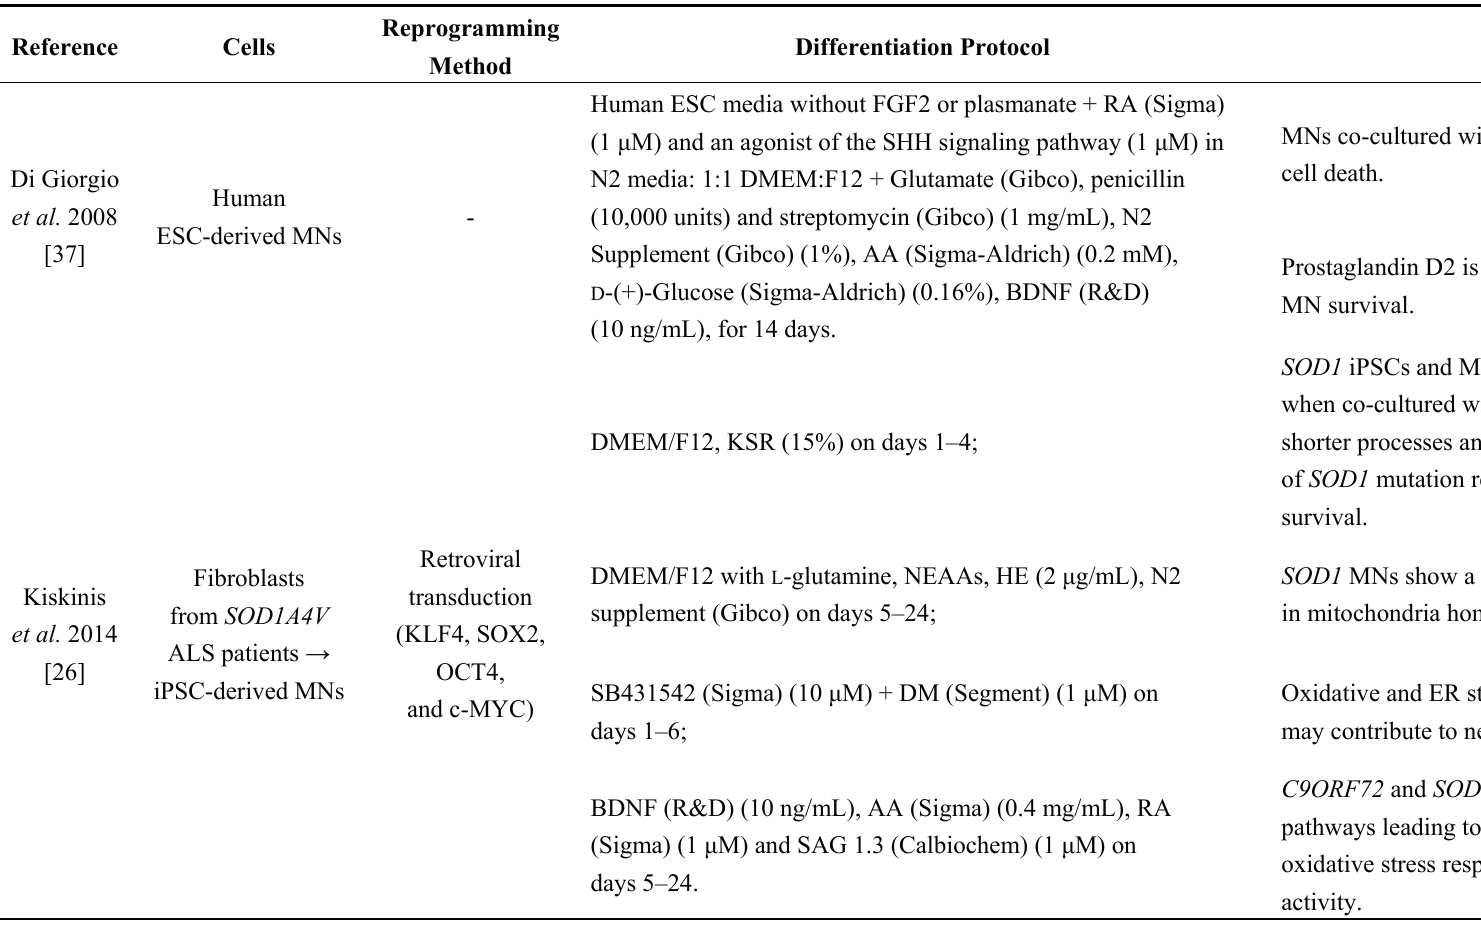
Table 1. iPSC-Based studies on amyotrophic lateral sclerosis/spinal muscular atrophy (ALS/SMA)